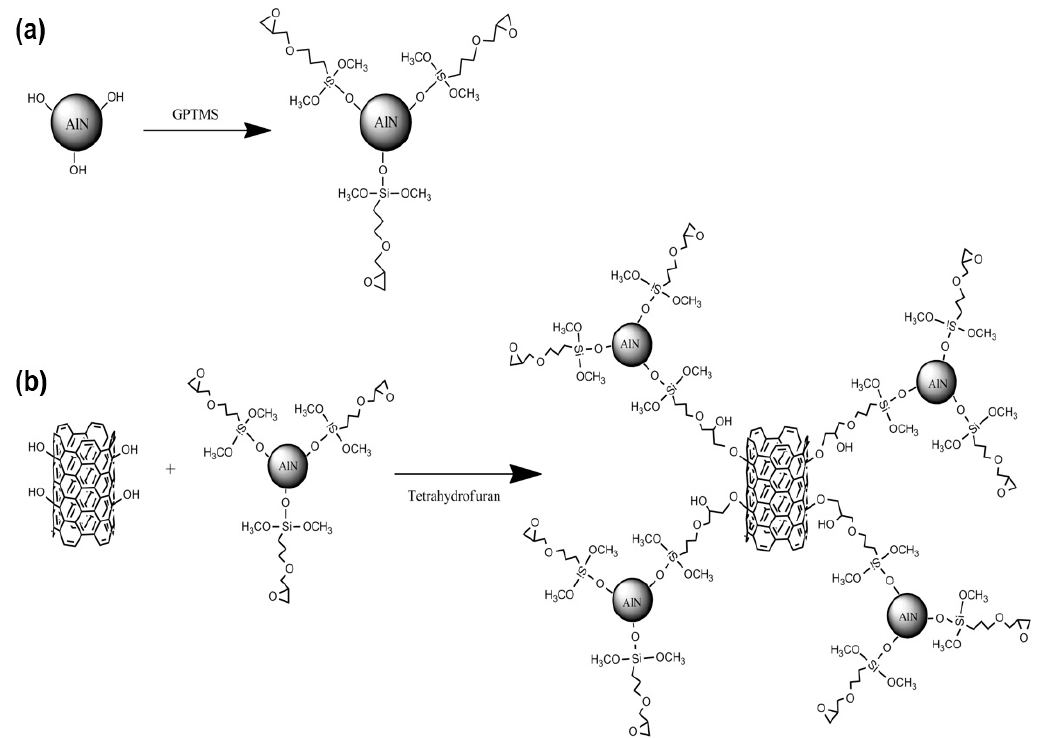
Figure 1. Schemes of the ( a ) silane treatment of AlN and ( b ) grafting reaction of the silane treated AlN on the covalently functionalized MWCNTs (fMWCNTs).